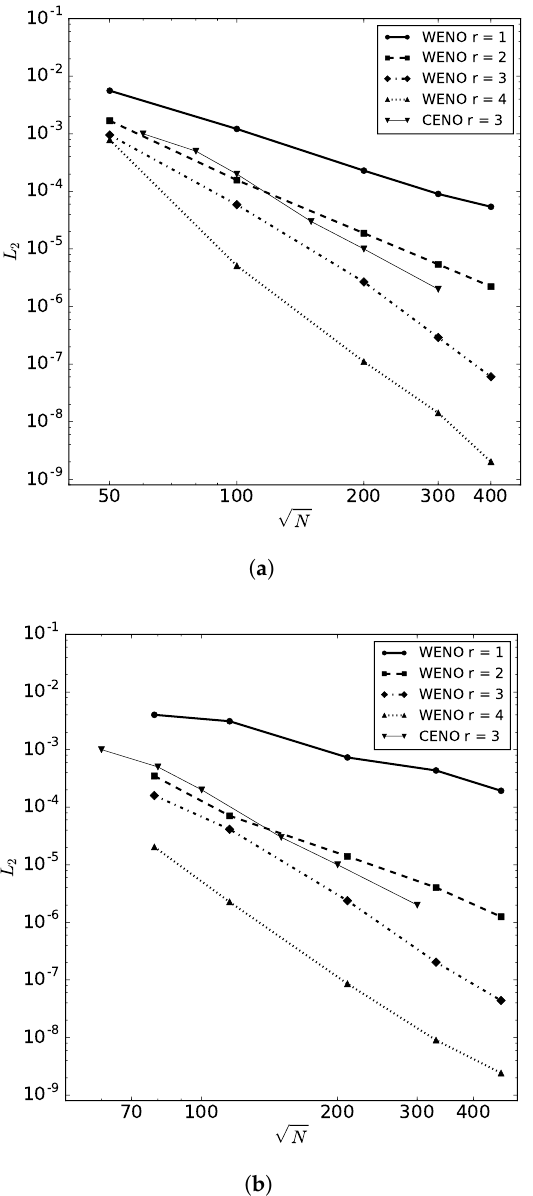
Figure 8. -norm of the error for the smooth, two-dimensional function. ( a ) 2500 hexahedra; L 2 ( b ) 6172